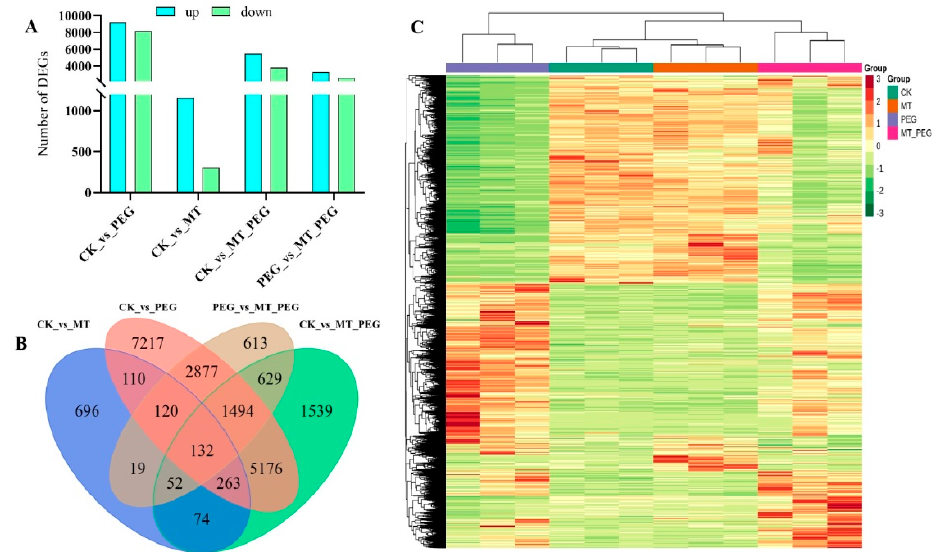
Figure 4. Overview of differentially expressed genes in chrysanthemum under different stresses. ( A ) DEGs (differentially expressed genes) in chrysanthemum under different stress conditions. ( B ) Venn diagram of DEGs from each comparison group. ( C ) Clustering heatmap of